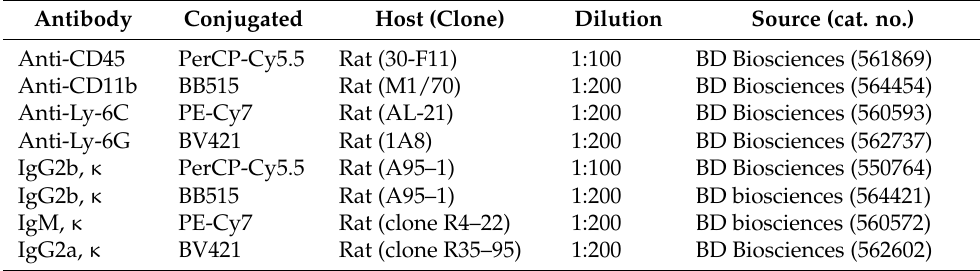
Table 5. Overview of antibodies used for flow